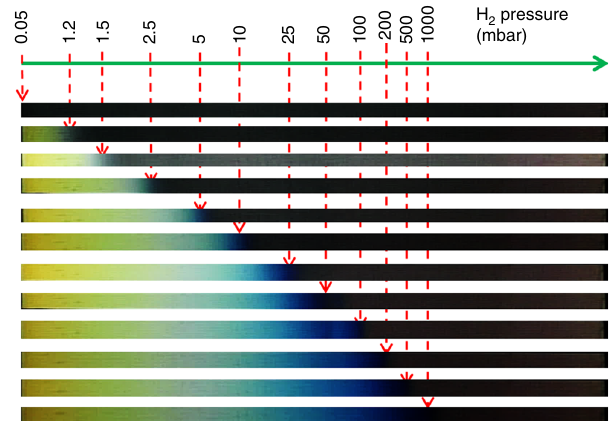
Fig. 5 Visible color changes associated with the formation of YH 3 in a 70 × 5 mm Y 97 Zr 3 – Y 90 Zr 10 gradient thin fi lm. The pictures represent consecutive stages in time of the thin fi lm hydrogenation at different H 2 pressures. The positions of the color front (indicated by the arrows) clearly depend on the hydrogen pressure and Zr concentration. Note that the thickness of the Pd cap layer used for this sample is 50 nm so as to enhance the optical contrast of the fi lm. The sample is viewed from the substrate